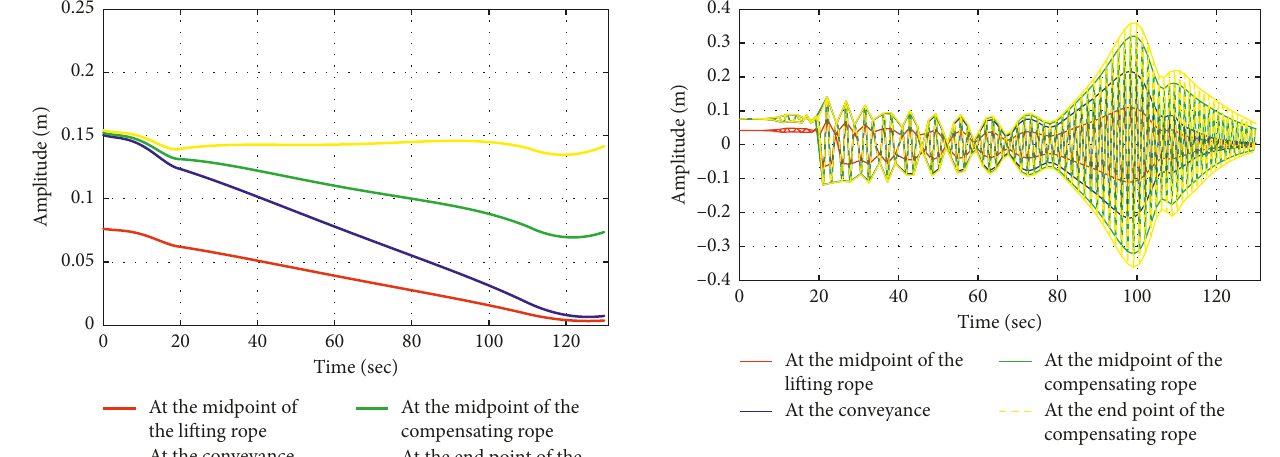
Figure 8: Longitudinal vibration of the traction system at different